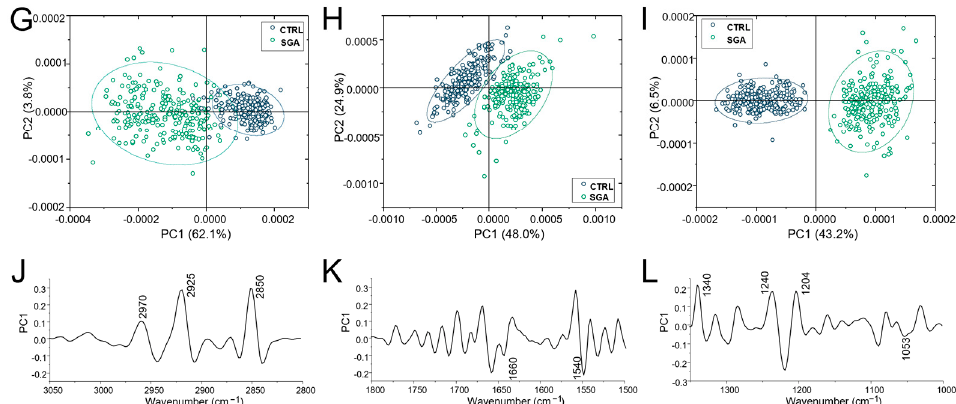
Figure 3. Multivariate analysis. PCA score plots and corresponding PC1 loadings calculated on CTRL, GDM, and SGA spectral populations in the 3050–2800 cm − 1 ( A , D and G , J ), 1800–1480 cm − 1 ( B , E and H , K ), and 1350–1000 cm − 1 ( C , F and I , L ) intervals. For a better comprehension, PC1 loadings of the three selected intervals are displayed with different Y scales. CTRL: control group (blue), GDM: gestational diabetes mellitus (purple), SGA: small-for-gestational-age (green).